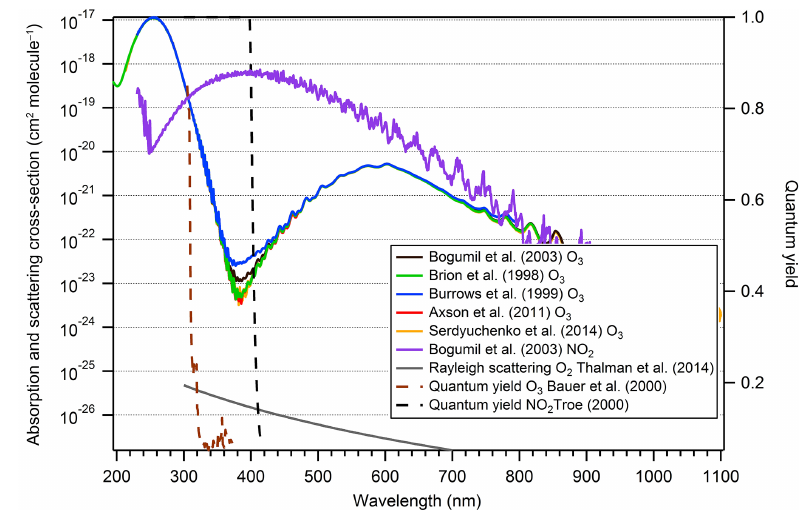
Figure 1. Spectral absorption cross sections and quantum yields of O 3 and NO 2